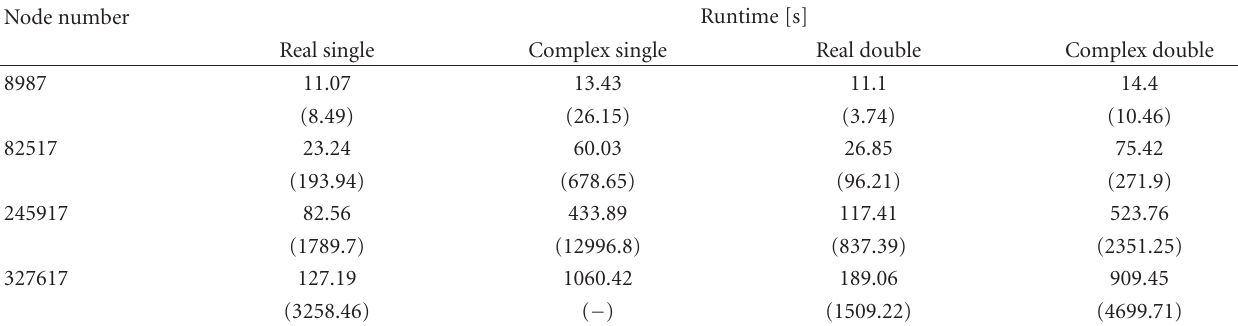
Table 2: GPU run-time comparisons for FEM forward solver computations of 80 source distributions in cylindrical meshes of di ff erent node densities. Real-valued problems were solved with a conjugate gradient solver, complex problems with a biconjugate gradient stabilised solver. Values in parentheses are CPU solution